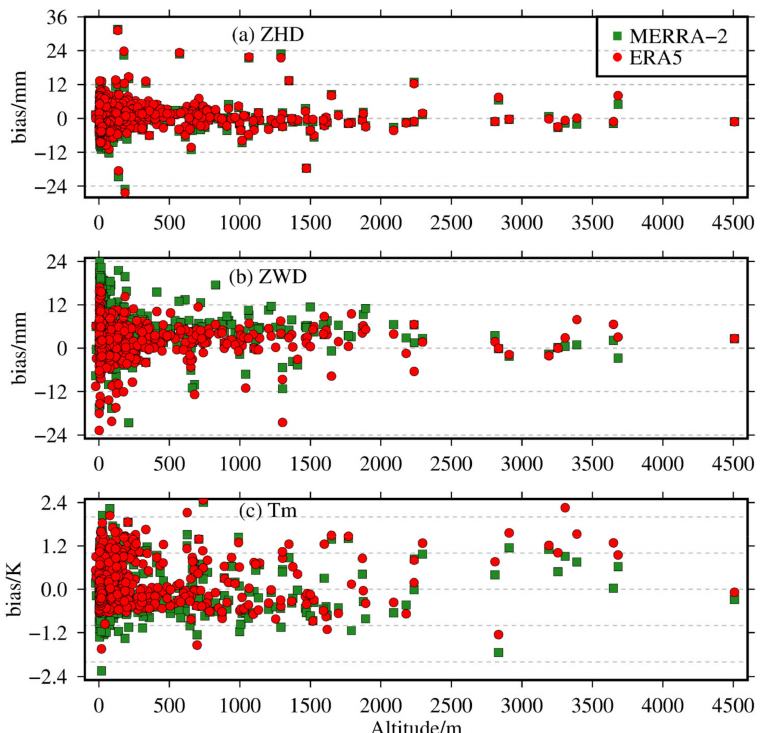
Figure 14. Variations with altitudes of the annual mean ( a – c ) bias values of ZHD, ZWD, and T m over the globe from 2016 to 2017.